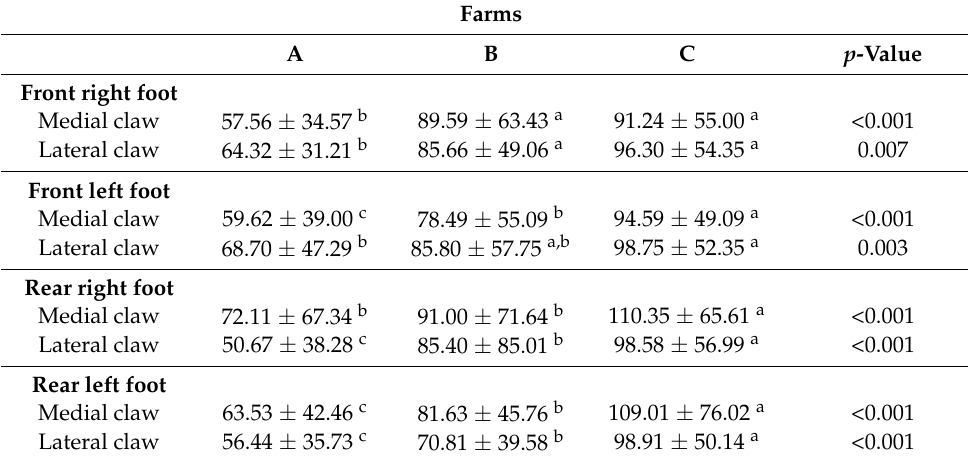
Table 1. Young’s modulus values (mean ± SD) in MPa of medial and lateral claws of all feet of culled sows from three genetic lines.